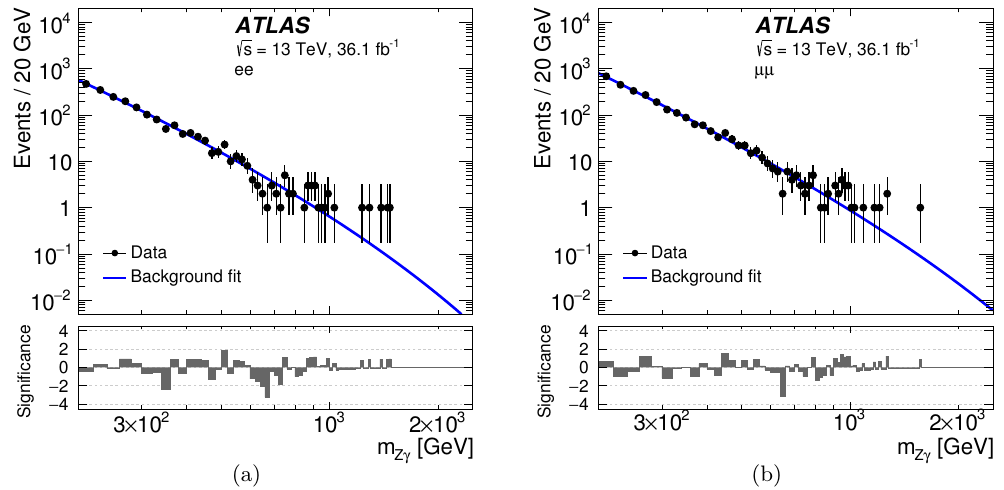
Figure 6 . The invariant Z(cid:13) mass ( m Z(cid:13) ) distributions of events satisfying the high-mass selection in data for the two event categories: (a) ee and (b) (cid:22)(cid:22) . The points represent the data and the statistical uncertainty. The solid lines show the background-only (cid:12)t to the data, performed independently in each category. The bottom part of the (cid:12)gures shows the signi(cid:12)cance, here de(cid:12)ned as the residual of the data with respect to the background-only (cid:12)t divided by the statistical uncertainty of the data.